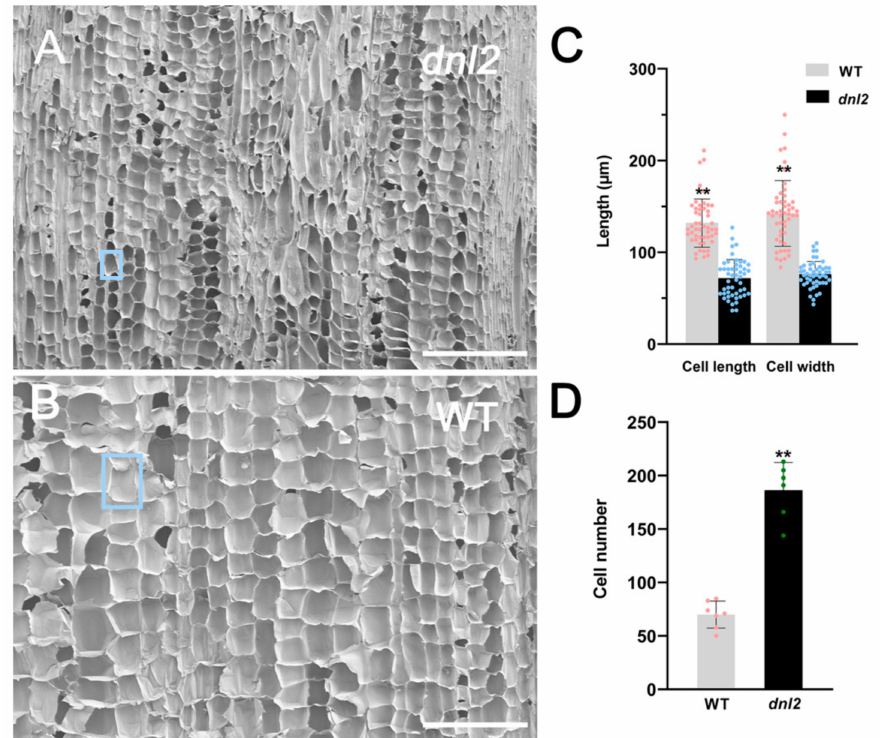
Figure 4. Longitudinal section of the seventh internodes at the V15 stage from dnl2 and the wild-type. ( A , B ) Longitudinal view of the parenchymal cells of dnl2 and the wild-type. ( C ) Length and width of the parenchymal cells. ( D ) Number of cells in visual field of dnl2 and the wild-type. The blue box indicates a single parenchymal cell. Asterisks indicate significant differences between dnl2 and the wild-type (** p < 0.01). Bars = 500 µ